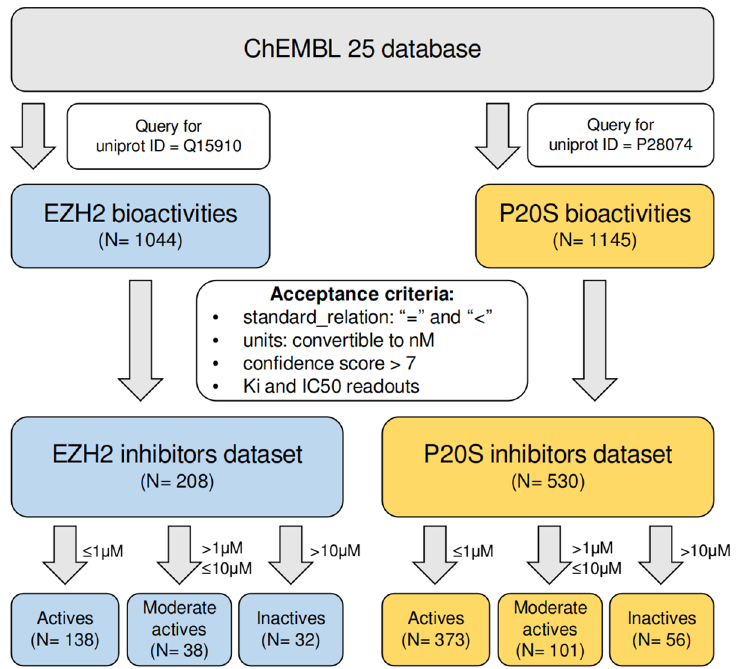
Figure 2. Overview of the assembly process for the EZH2 inhibitors and the P20S inhibitors datasets.